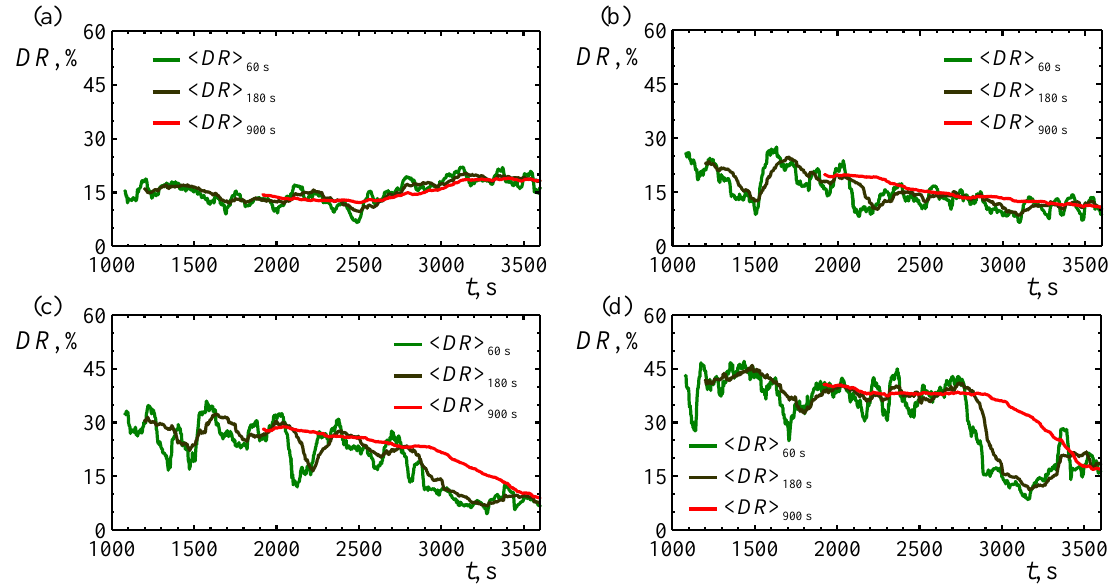
Figure 10. Time evolution of DR at four monitoring points: ( a ) z = 0.1 m, ( b ) z = 0.6 m, ( c ) z = 1.1 m, and ( d ) z = 1.7 m (data for θ = 25°, case #1).